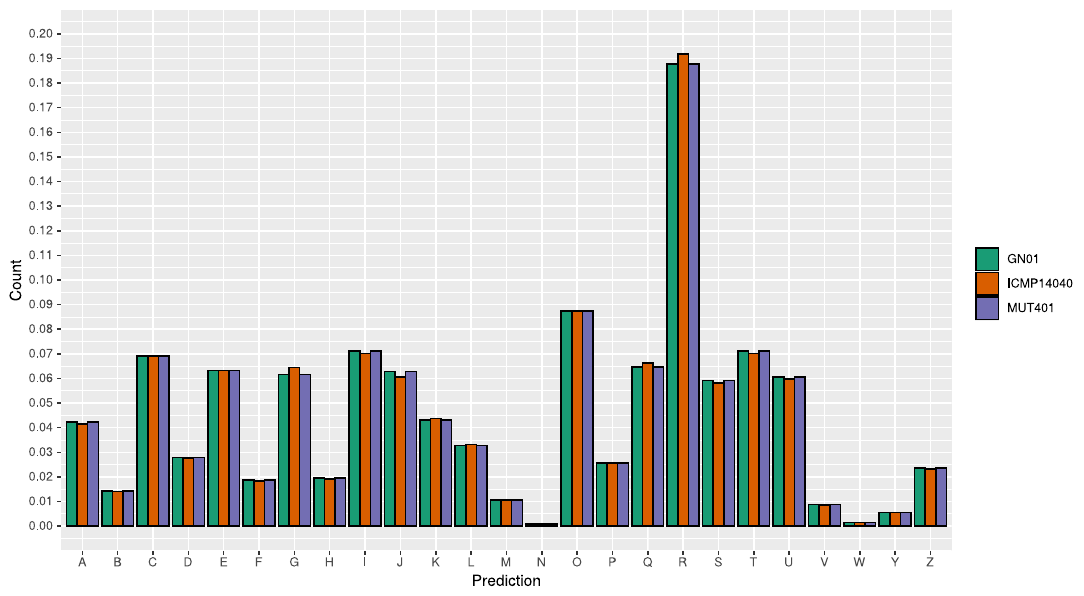
Figure 4. Frequency of the annotated euKaryotic Orthologous Groups (KOG). A: RNA processing and modification, B: Chromatin structure and dynamics, C: Energy production and conversion, D: Cell cycle control, cell division, chromosome partitioning, E: Amino acid transport and metabolism, F: Nucleotide transport and metabolism, G: Carbohydrate transport and metabolism, H: Coenzyme transport and metabolism, I: Lipid transport and metabolism, J: Translation, ribosomal structure and biogenesis, K: Transcription, L: Replication, recombination and repair, M: Cell wall/membrane/envelope biogenesis, N: Cell motility, O: Posttranslational modification, protein turnover, chaperones, P: Inorganic ion transport and metabolism, Q: Secondary metabolites biosynthesis, transport and catabolism, R: General function prediction only, S: Function unknown, T: Signal transduction mechanisms, U: Intracellular trafficking, secretion, and vesicular transport, V: Defense mechanisms W: Extracellular structures, Y: Nuclear structure, Z: